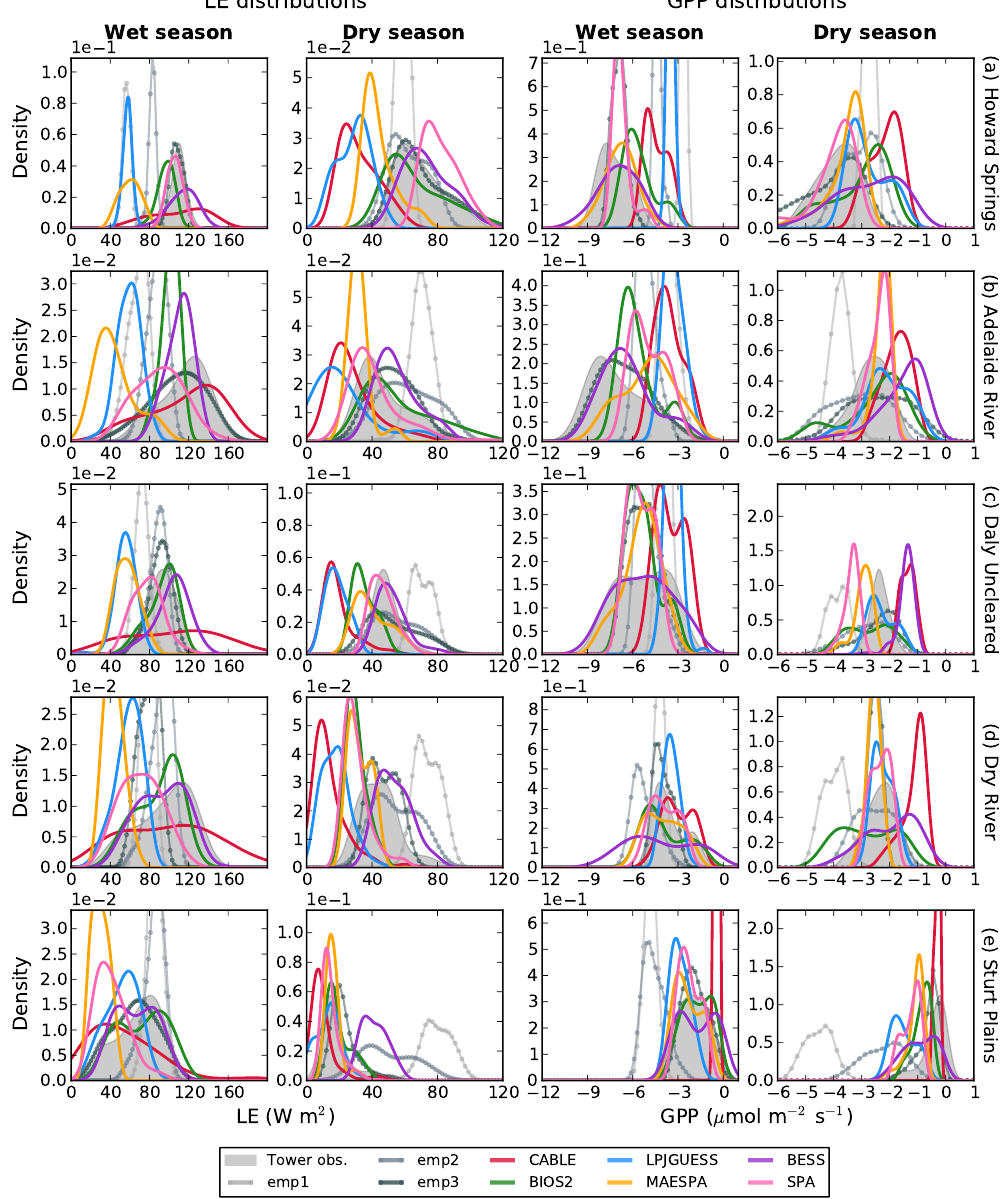
Figure 3. Probability densities (expressed in scientific notation) of daily mean latent heat (LE) flux and gross primary productivity (GPP) at each of the five savanna sites, where the distributions for each flux are partitioned into wet and dry seasons. The order of the sites are from wettest to driest; (a) Howard Springs, (b) Adelaide River, (c) Daly River, (d) Dry River, and (e) Sturt Plains. The grey region is the tower flux, while the dotted lines are the empirical benchmarks. Predicted LE and GPP probability densities from each of the six process-based models are given by a spectrum of colours described in the